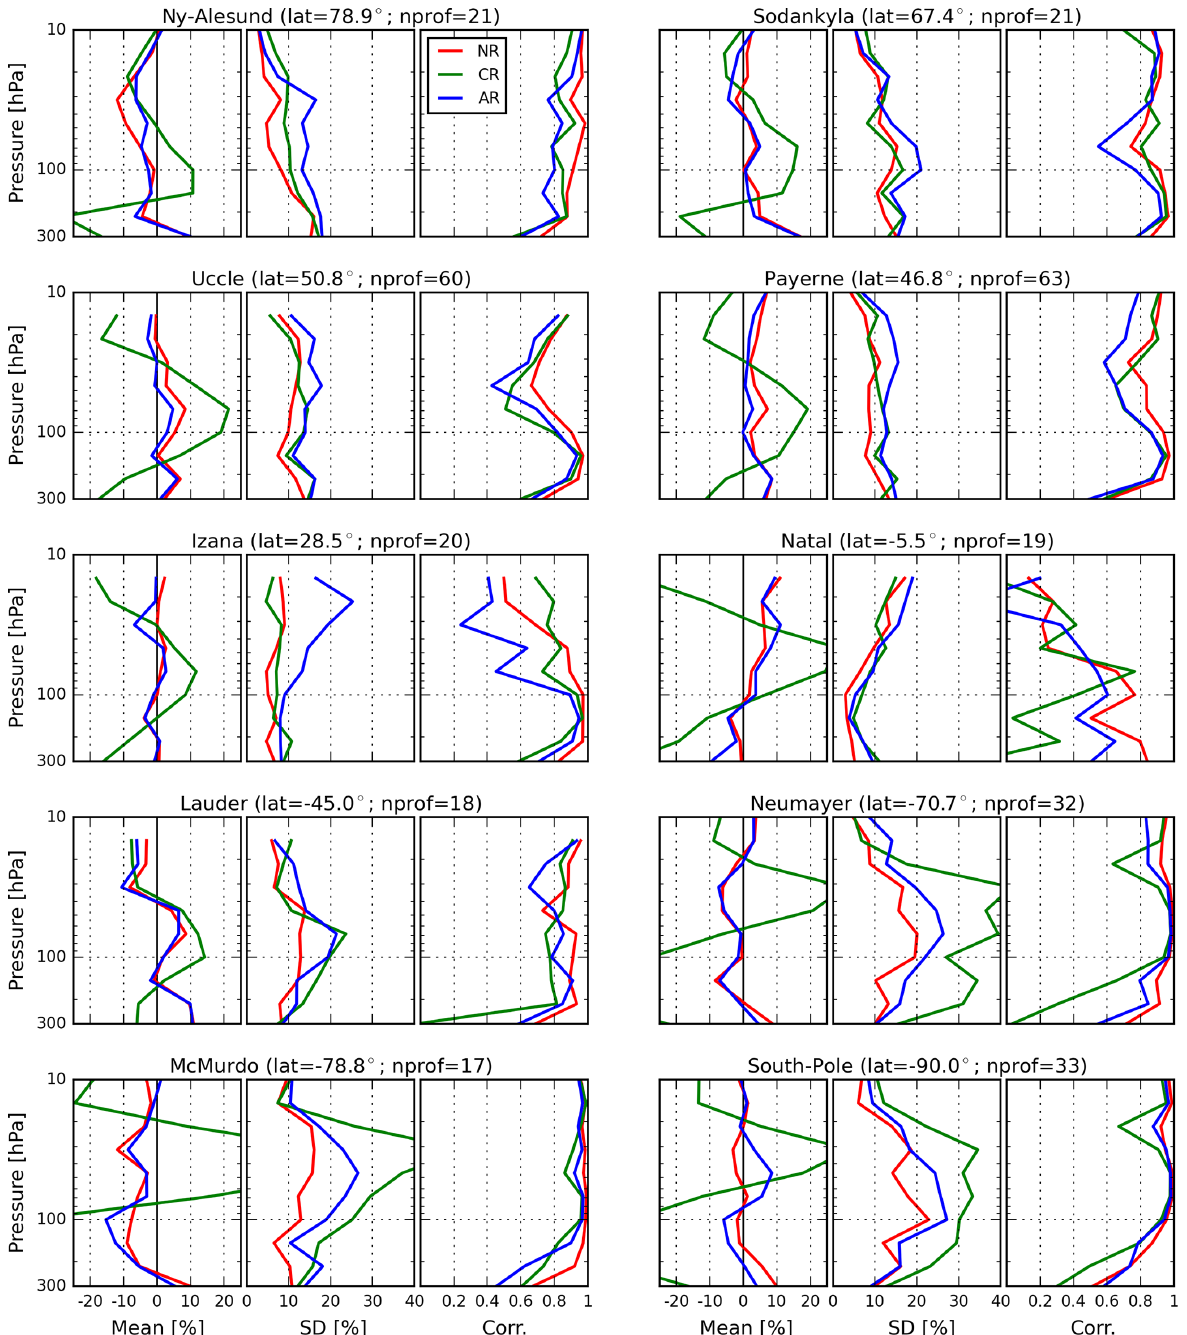
Figure 3. Comparison between ozonesonde profiles and the nature run (red line), the control run (green line) and the assimilation run (blue line) for the period 1 June–25 October 2009 at 10 stations of the Network Detection for Atmospheric Composition Change (NDACC). For each station are shown the mean differences between the BASCOE runs and the ozonesondes normalized by the ozonesonde values (%, left plot), the associated standard deviation (%, centre plot) and the sample correlation coefficients between the BASCOE runs and ozonesondes (right plot). The latitude of the station and the number of soundings are given in the title of each group of three